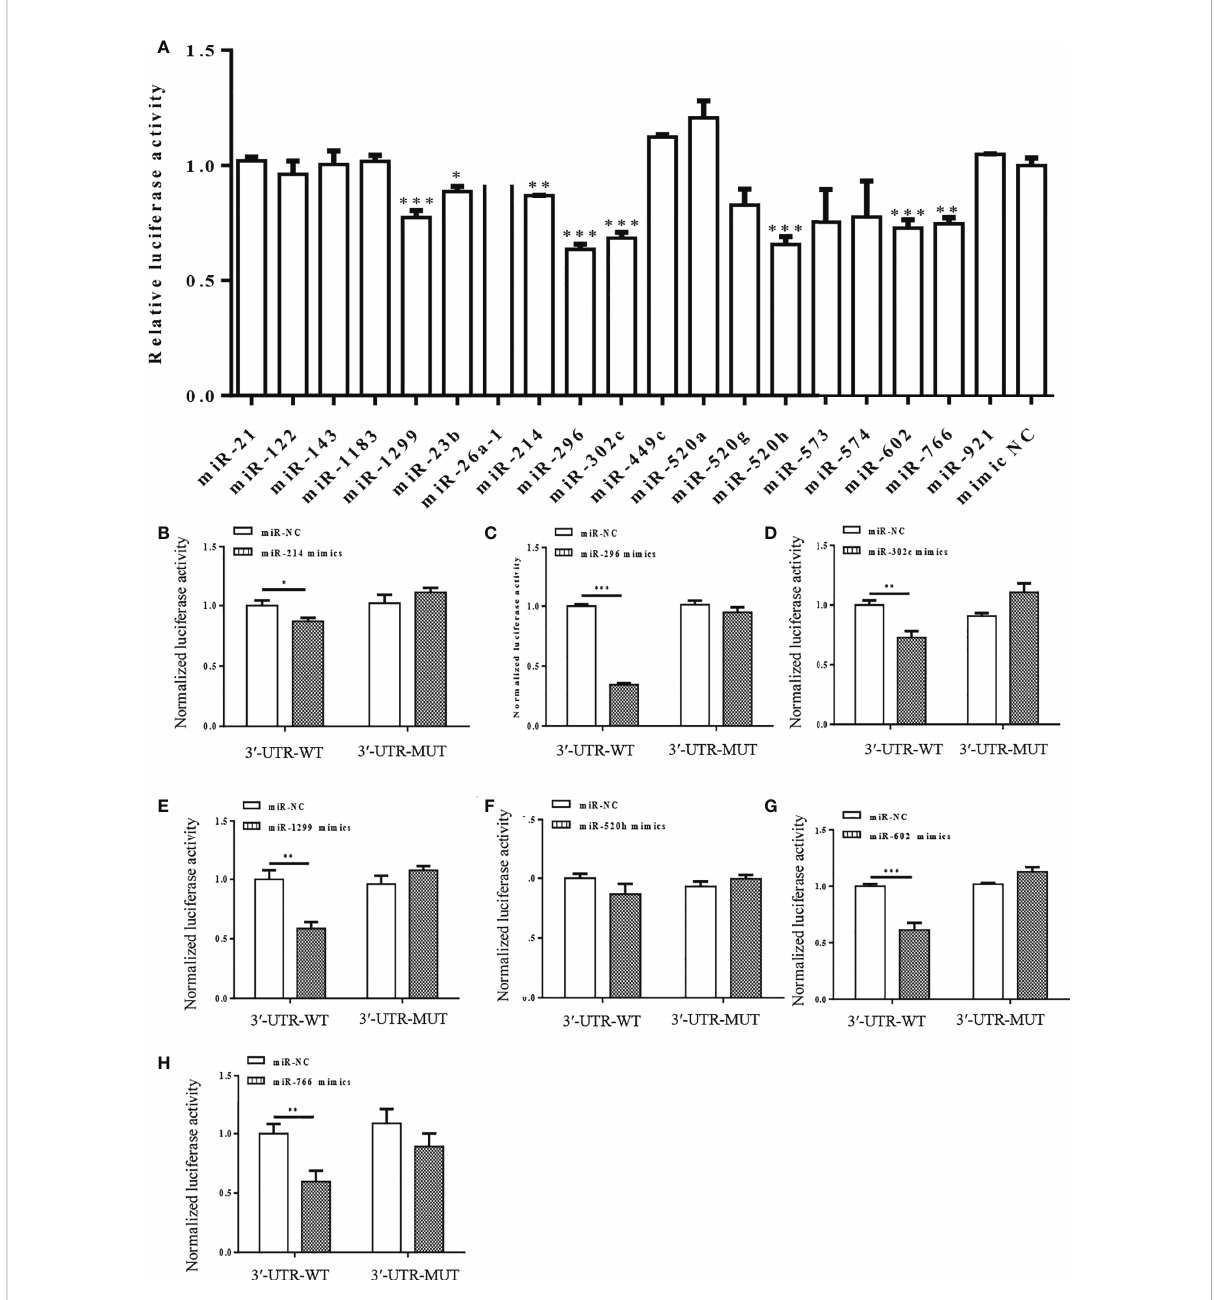
FIGURE 2 Dual-luciferase reporter assay showing interaction between human miRNAs and S-3 ′ UTR of SARS-CoV-2. (A) Luciferase activity was detected 48 h after co-transfection of cells with S-3 ′ UTR-WT reporter and miR-NC or miRNA mimics. (B-H) Normalized Luciferase activity was detected 48 h after co-transfection of cells with S-3 ′ UTR-WT and S-3 ′ UTR-MUTANT reporter and miR-NC or miRNA mimics. miRNAs include miR-214 (B) , miR-296 (C) , miR-302c (D) , miR-1299 (E) , miR-520h (F) , miR-602 (G) , and miR-766 (H) . (*p<0.05, **p<0.01,